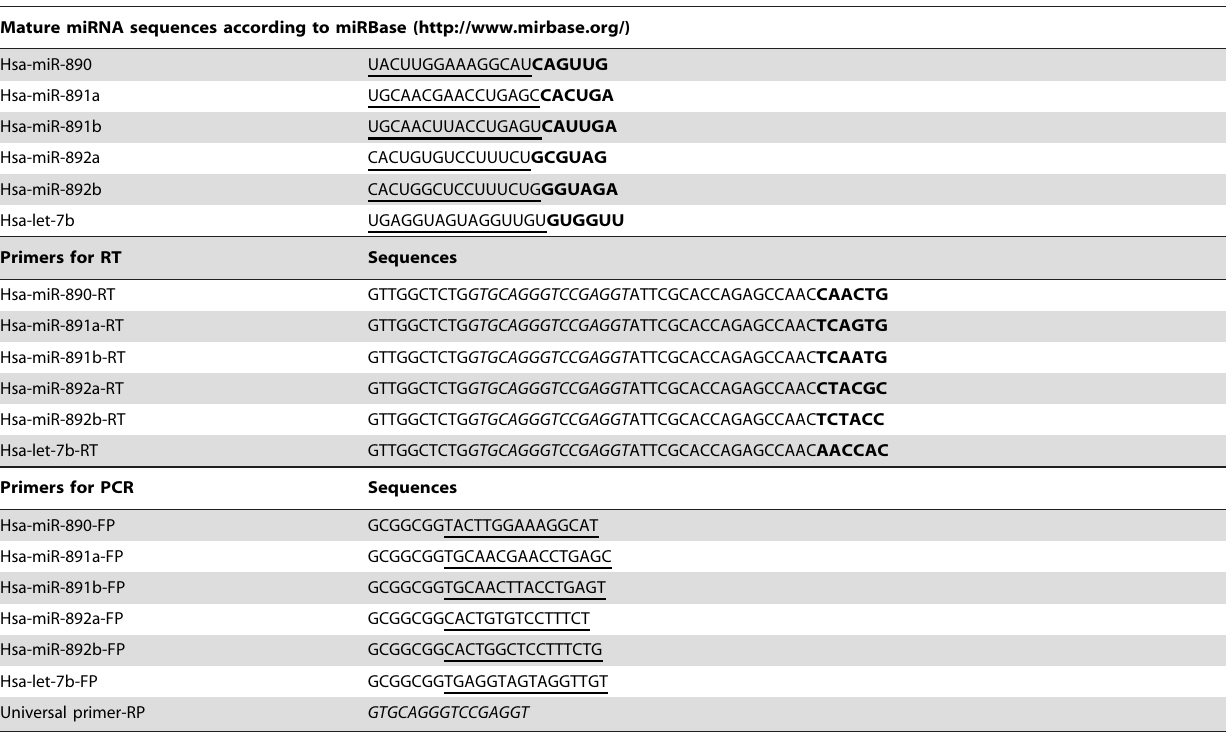
Mature miRNA sequences according to miRBase